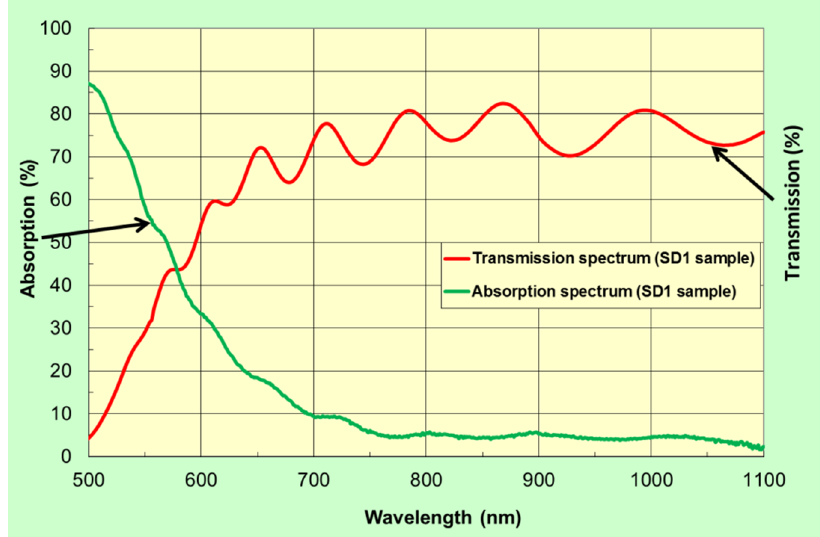
Figure 1. Transmission and absorption spectra of a multilayer garnet structure (SD 1); (red line) is the measured transmission spectrum of a structure, which was annealed with an optimized annealing regime (3 h at 630 °C) and (green line) is the measured absorption spectrum of this